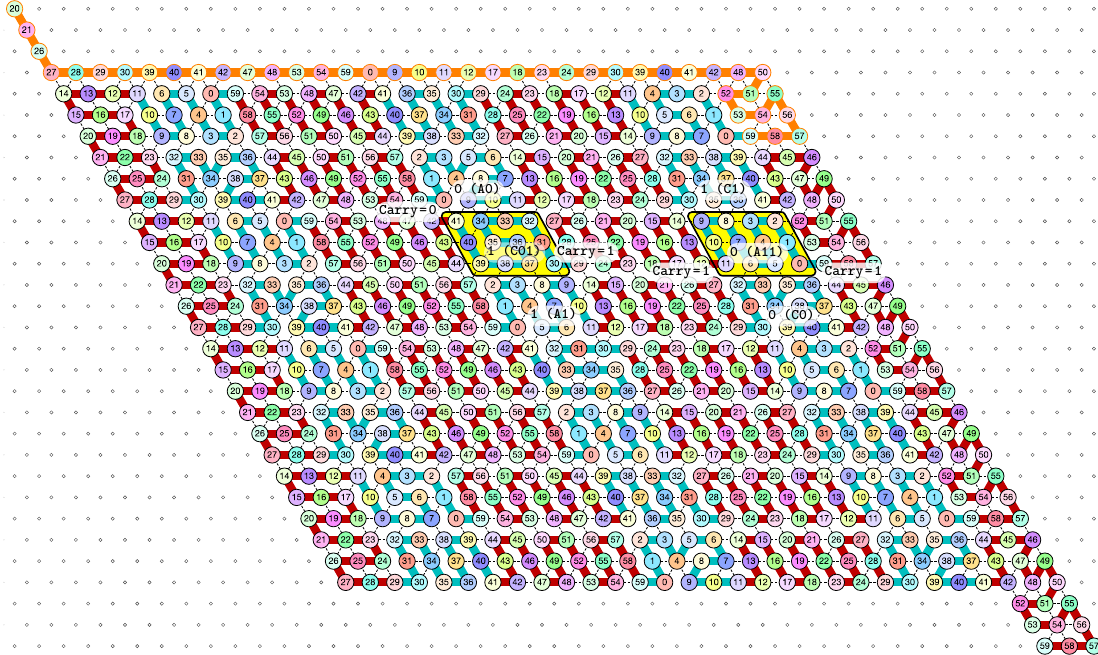
Figure 12. The folding of the 3-bits counter upto value 3 “ 011 in binary. Observe the carry propagation in the second zig